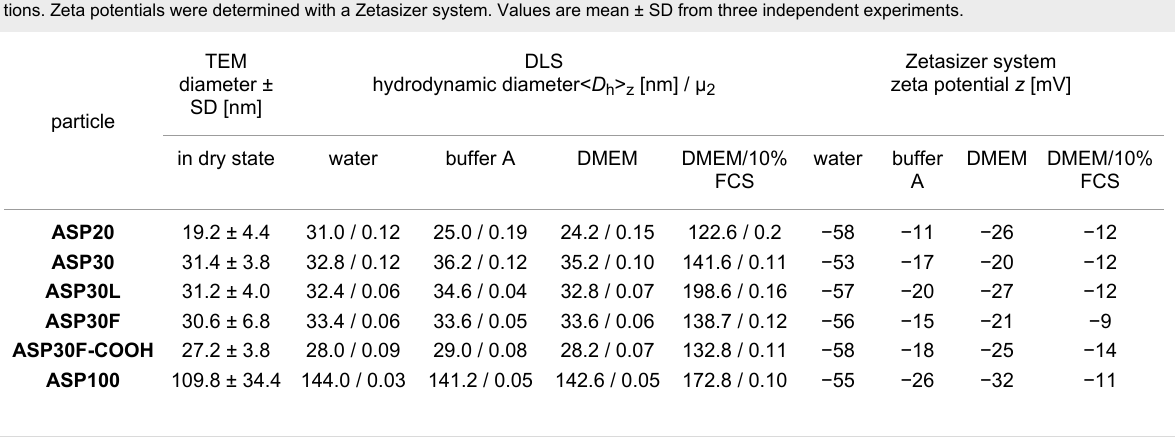
Table 1: Physico-chemical characterization of ASP used in the study. The average size of the different ASP was determined in dry state (TEM) as well as in water, buffer A, and DMEM with or without 10% FCS by angular-dependent DLS measurements with a goniometer setup by ALV. The values of µ 2 as a measure for the size polydispersity are derived directly from the cumulant analysis of DLS autocorrelation data. As a rough estima- tion,